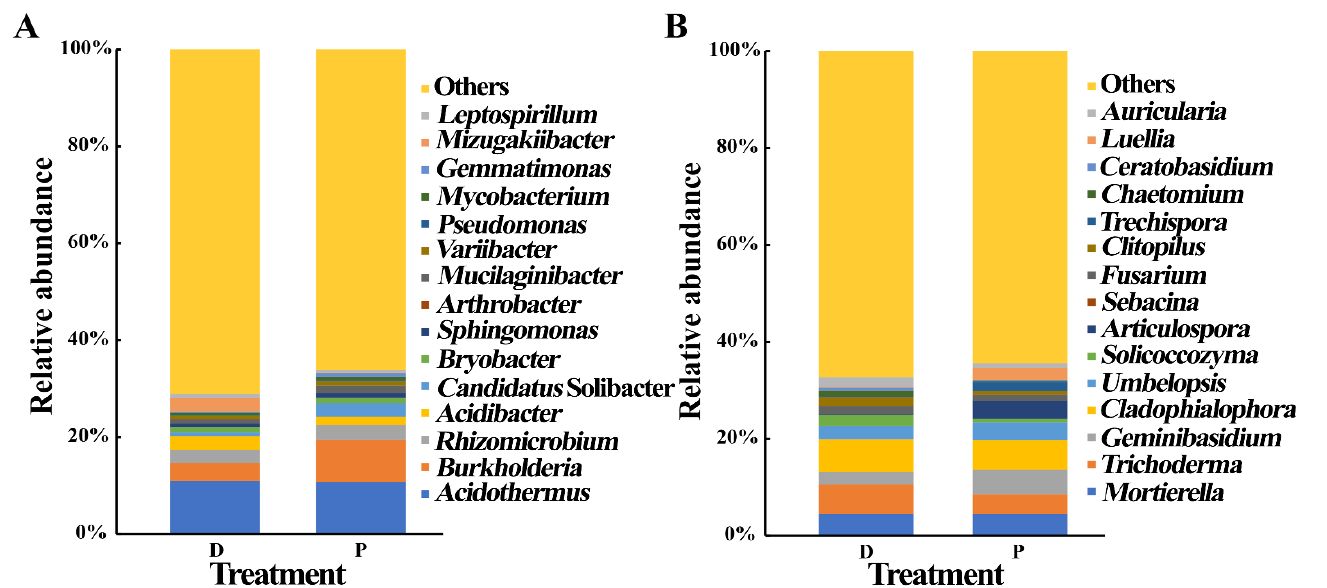
Figure 3. Effect of the fungicide prochloraz on the relative microbial abundance of bayberry rhizo- sphere soil at the genus level. ( A ) Bacteria; ( B ) Fungi. D and P represent decline-diseased trees only and in combination with the fungicide prochloraz, respectively. Table 3. The effect of prochloraz on rhizosphere soil pH and physical and chemical properties of decline-diseased